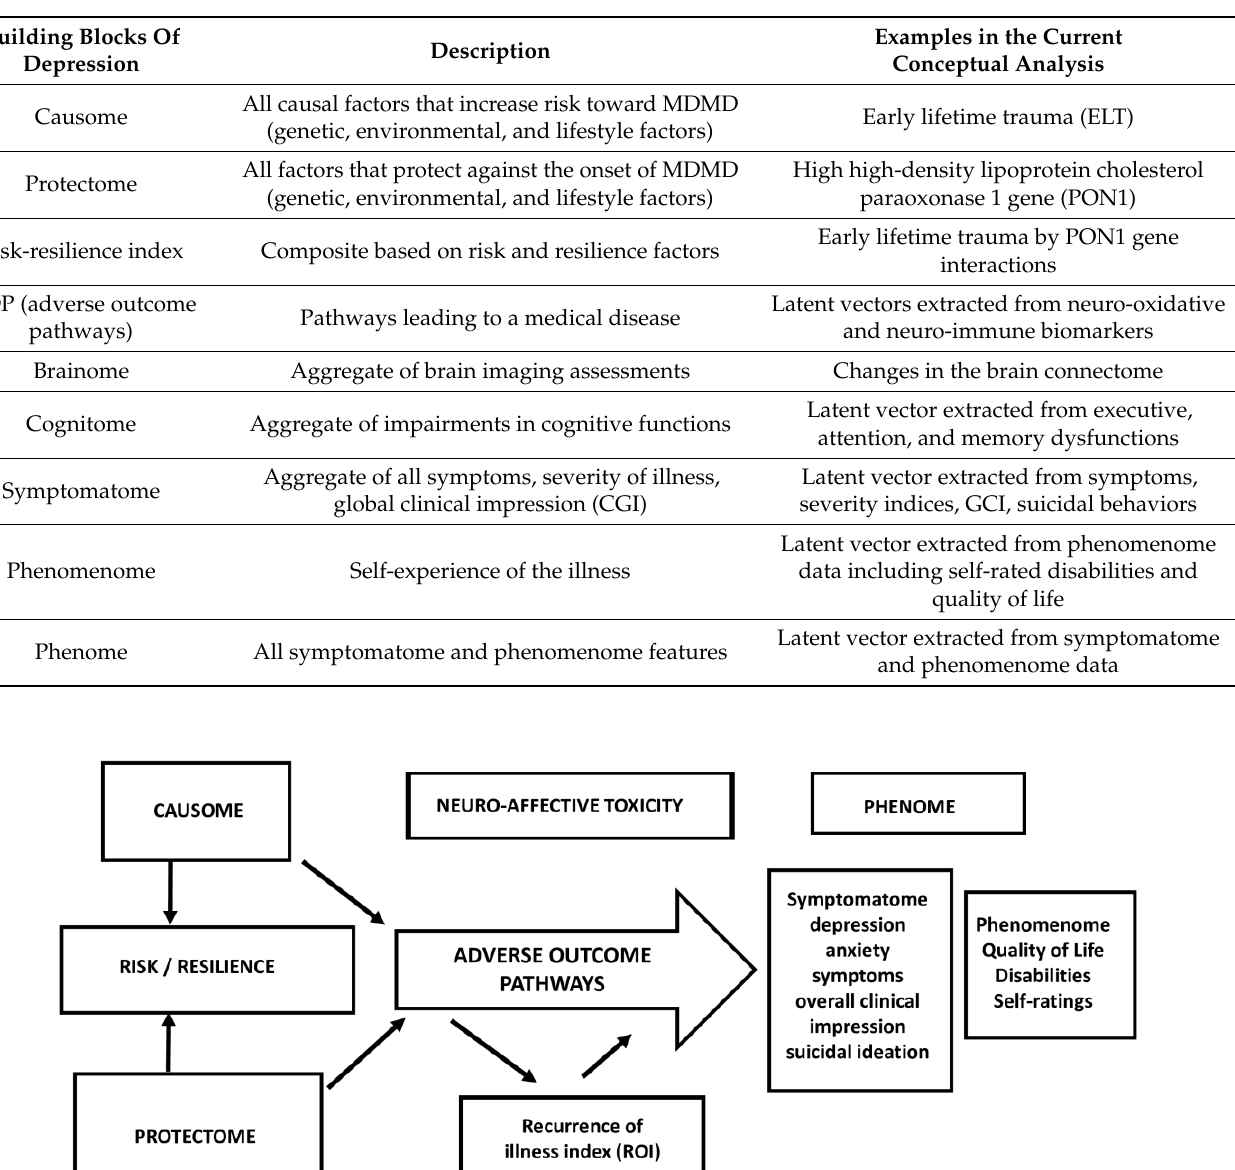
Table 2. Building blocks included in the digital models of major dysmood disorder (DMDM).